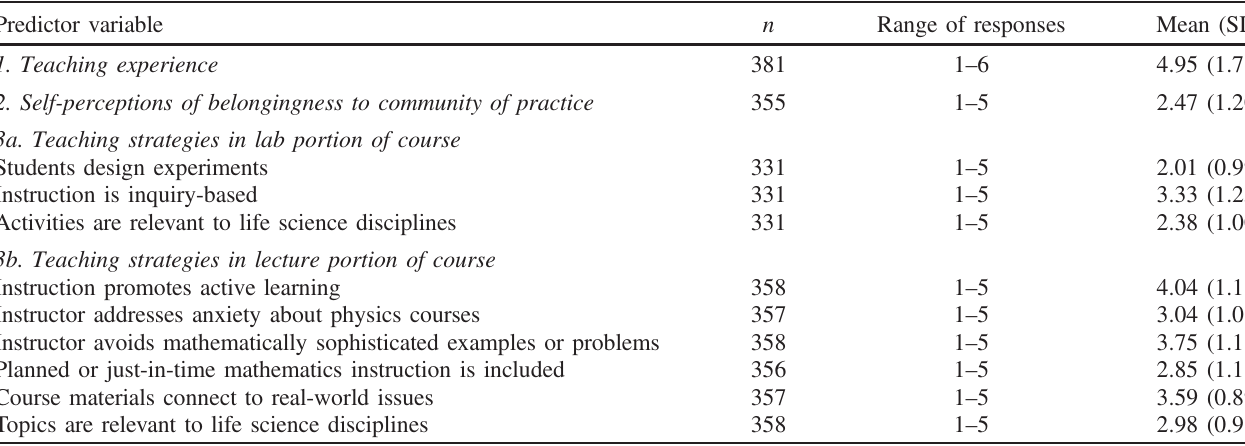
TABLE I. Descriptive statistics for predictor